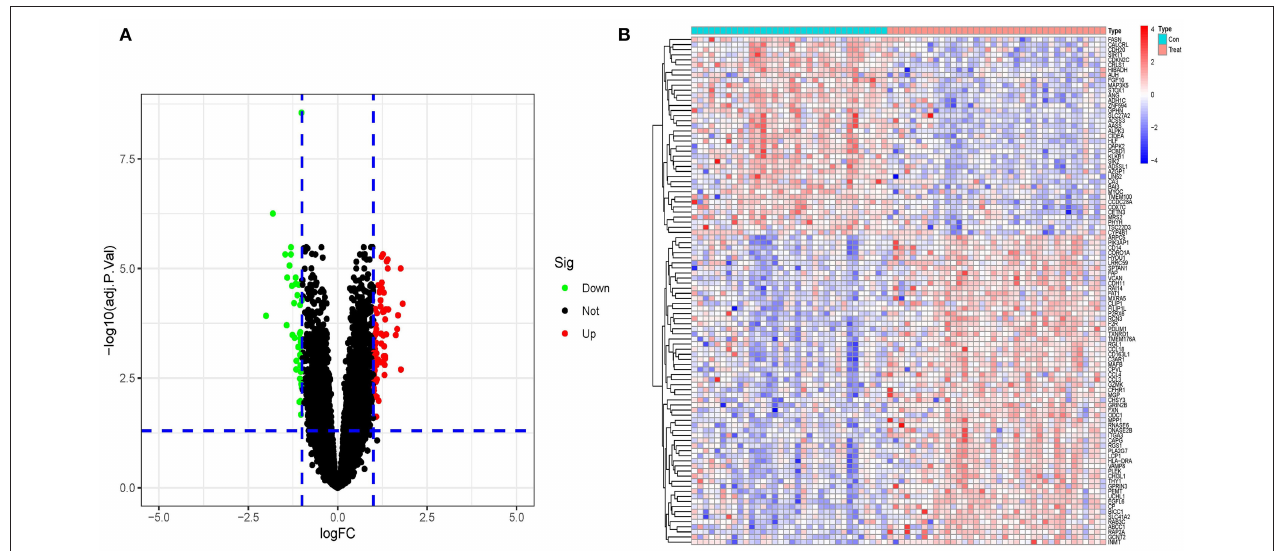
FIGURE 2 | (A) A volcano plot representing the findings of differential expression investigation. The remaining functional genes are shown by the black dots. (B) A DEG heatmap. The graph’s hues, which range from red to green, represent high to low expressiveness. The red band in the top half of the heatmap represents illness samples, whereas the blue band represents normal samples.